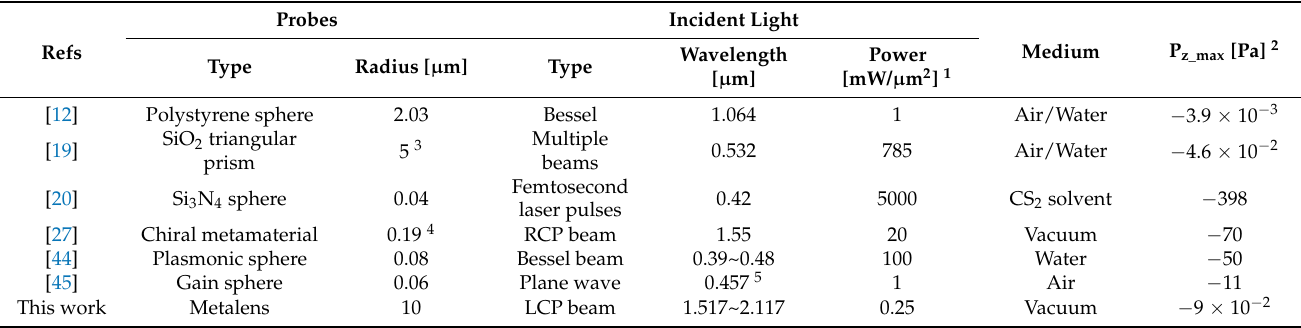
Table 1. The detail parameters of the different OPF